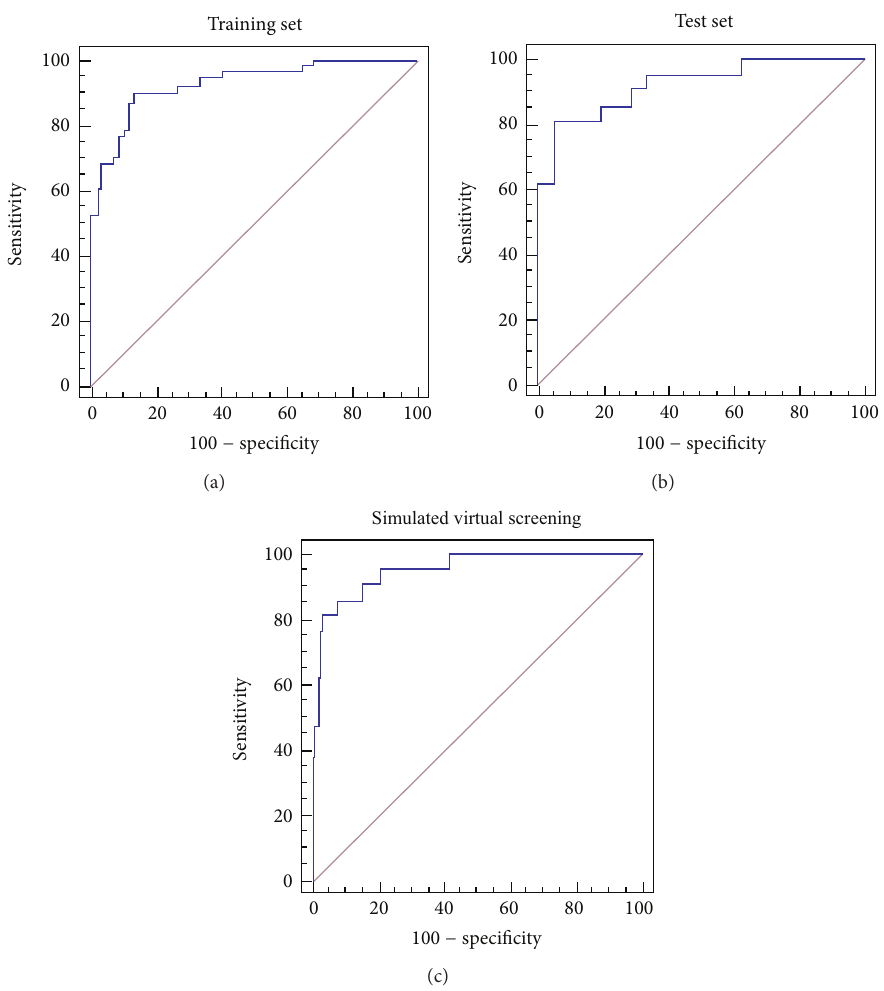
Figure 4: Training set (a), test set (b), and simulated database (c) ROC curves.